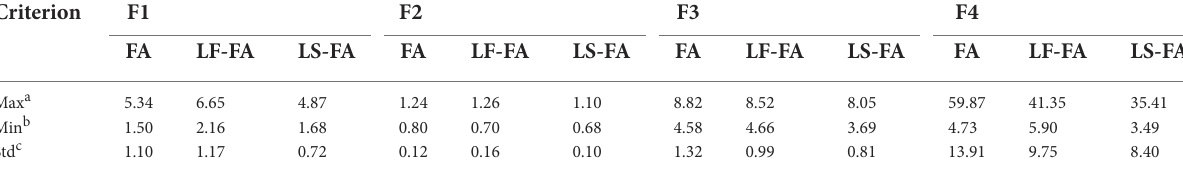
TABLE 1 PerformanceofFA,LF-FA,andLS-FA.